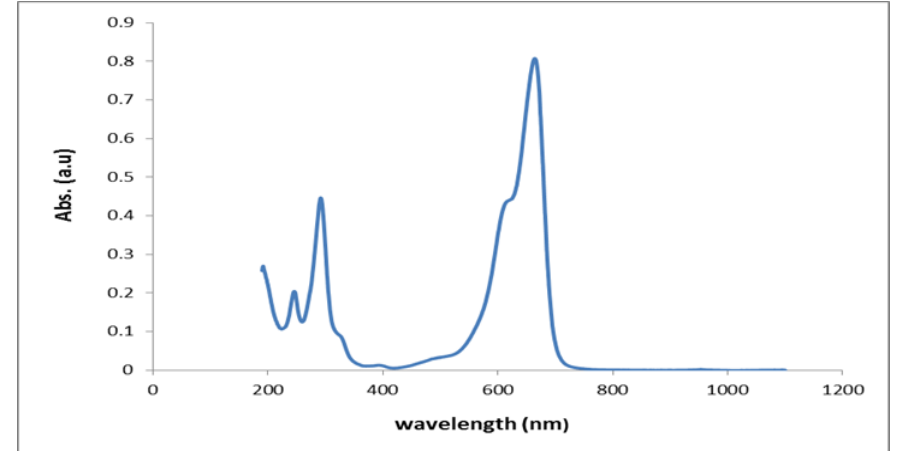
Fig.2: Absorption spectra of